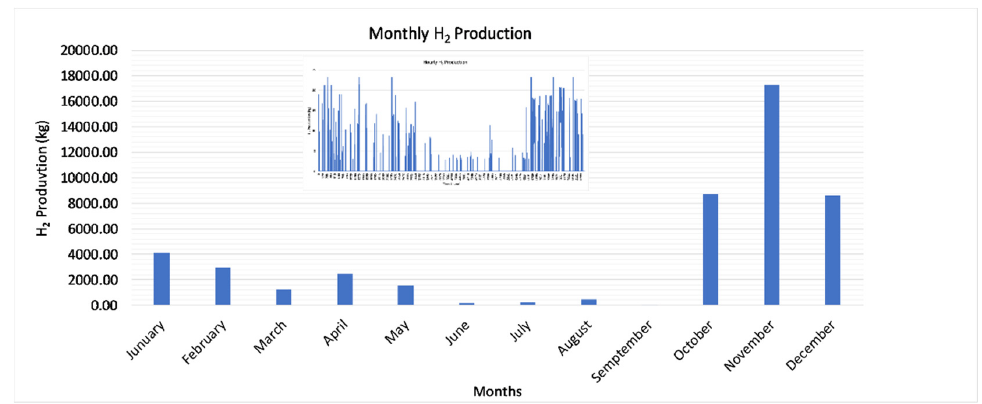
Figure 3. H 2 production from the energy surplus of the wind park on an hourly basis (upper right) and monthly production.